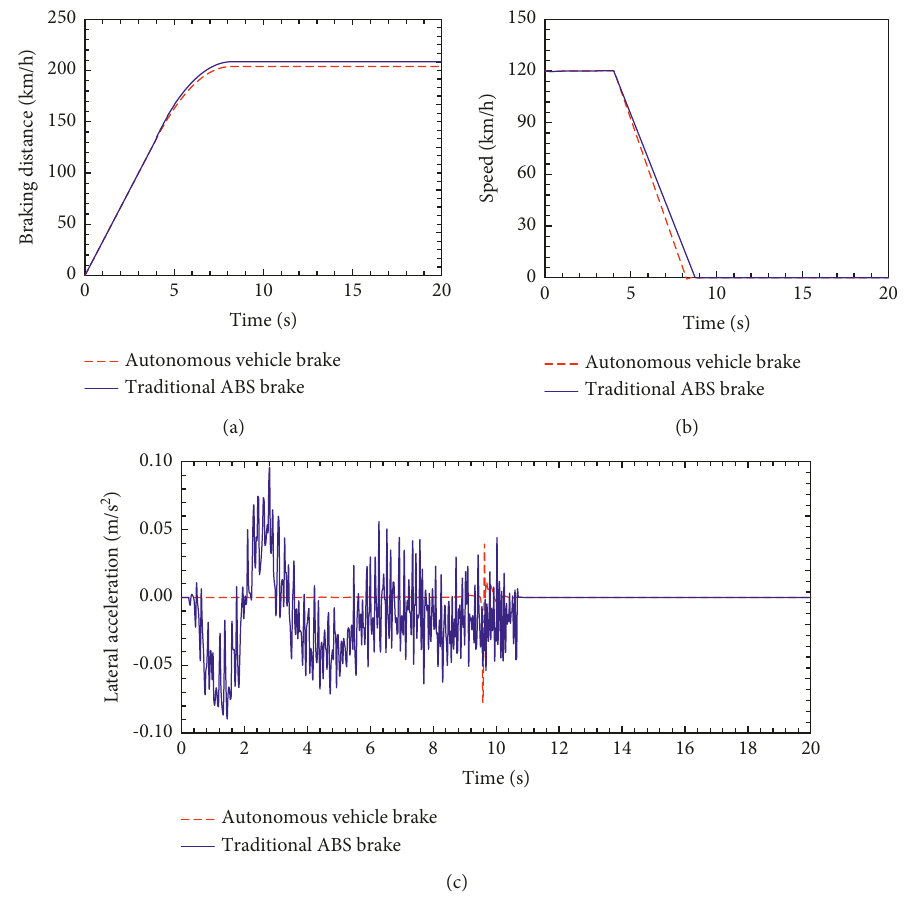
Figure 6: Braking performance analysis: (a) braking distance; (b) speed-time curve; (c) lateral